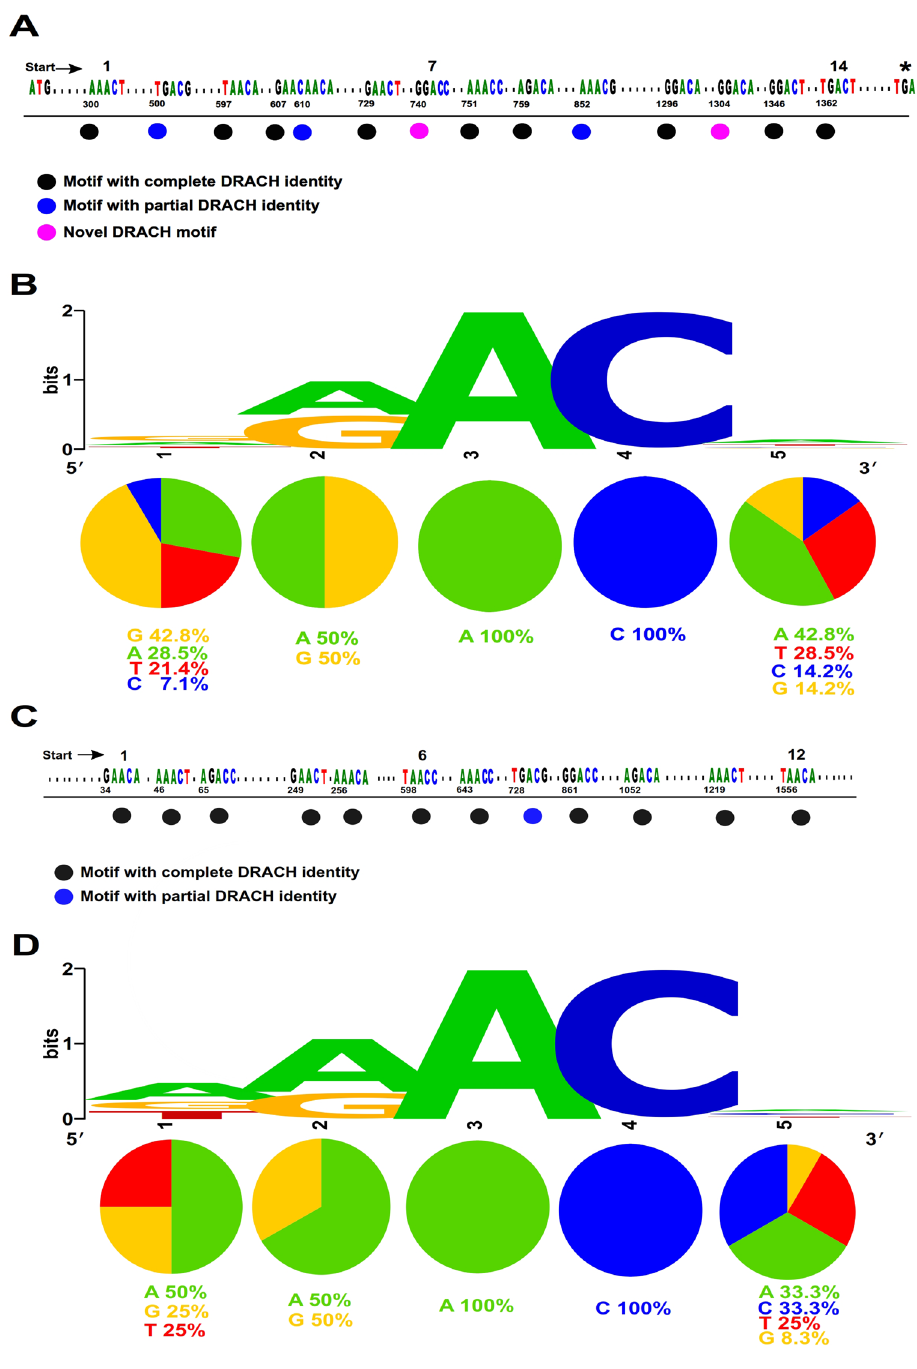
Figure 1. Locations and conserveness of the DRACH motifs utilized in this study. Schematic representation of locations of the putative motifs on the IAV-PR8 HA mRNA ( A , B ) and vRNA ( C , D ), accession no. AF389118, which coincident with the 8/9 m 6 A peaks identified in 4 that are indicated by numbers. Motifs contain the complete, partial, and novel DRACH are indicated by coloured circles. ( B , D ) WebLogo-based diversity and/or conserveness of nucleotides in the proposed DRACH motifs in PR8 HA mRNA ( B ) and vRNA ( D ), one stack for each position in the sequence, the height of the stack indicates the sequence conservation at that position, the height of symbols within the stack indicates the relative frequency of each nucleotide at that position. The percent of each nucleotide in each position are indicated by coloured pie